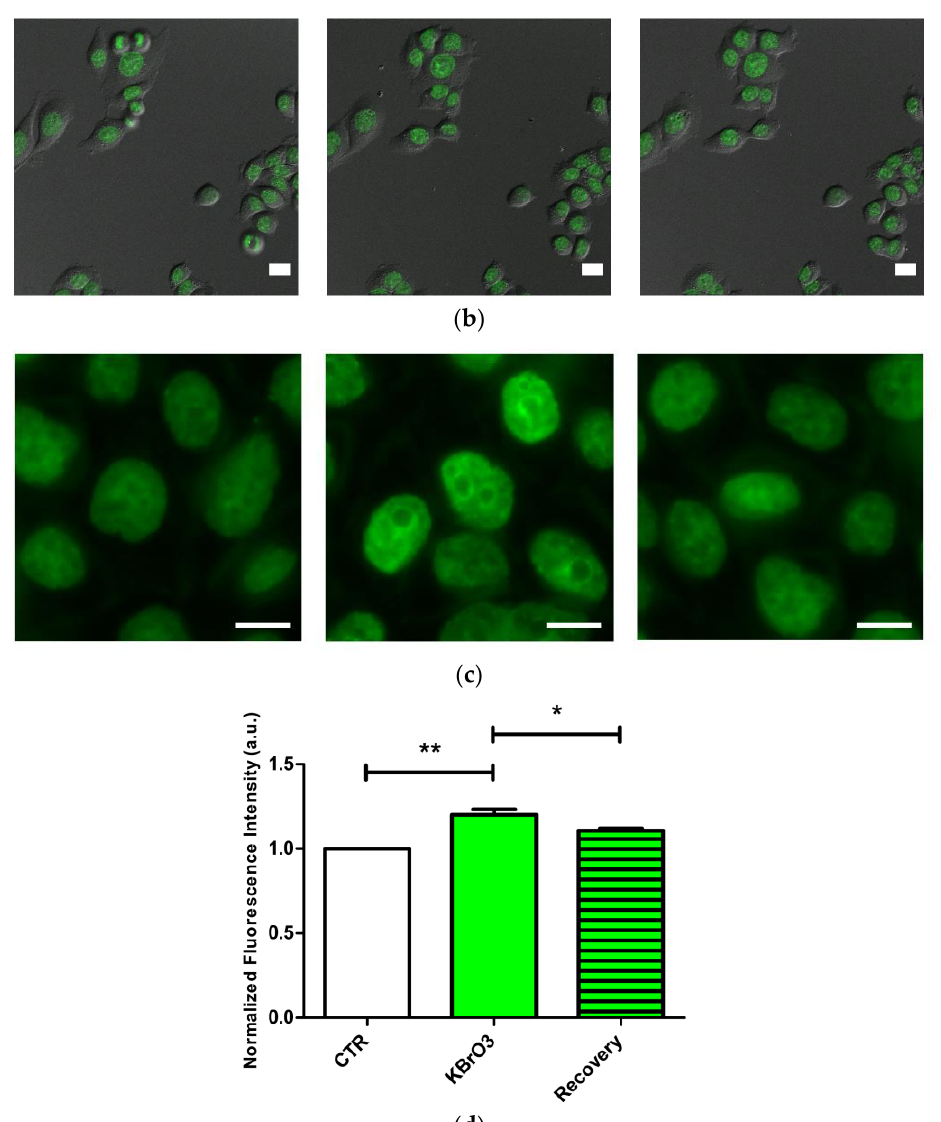
Figure 5. ( a ) Ultrastructural analysis of cell treated with potassium bromate. KBrO 3 does not alter the subcellular environment: note the active mitochondria morphology (arrowheads), the unaltered RER and ribosomes (flagged arrows); few heterochromatic areas (Ch) are visible in the nucleus. Bars: 1 μm. ( b ) Timelapse frames (pre-, during and post-treatment respectively) showing rapid chromatin reorganization in clusters in cells subjected to KBrO 3 oxidative insult. Bars: 10 μm. ( c ) Note the difference in chromatin fluorescence between pre-KBrO 3 treatment (left panel), during the oxidative stress (middle panel) and during the recovery phase (right panel) . Bars: 10 μm. ( d ) The histogram shows the significant KBrO 3 -induced increment of the nuclear fluorescent signal, indicative of the formation of signal-positive condensed chromatin cluster (*: p Value < 0.05; **: p Value < 0.01).